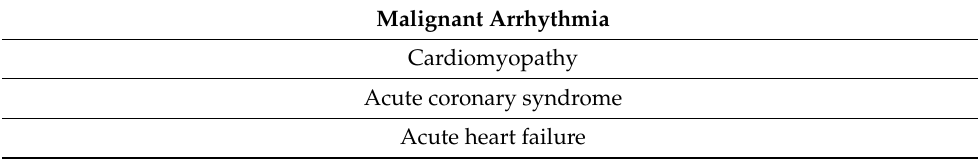
Table 1. Cardiovascular manifestations associated with pheochromocytoma.